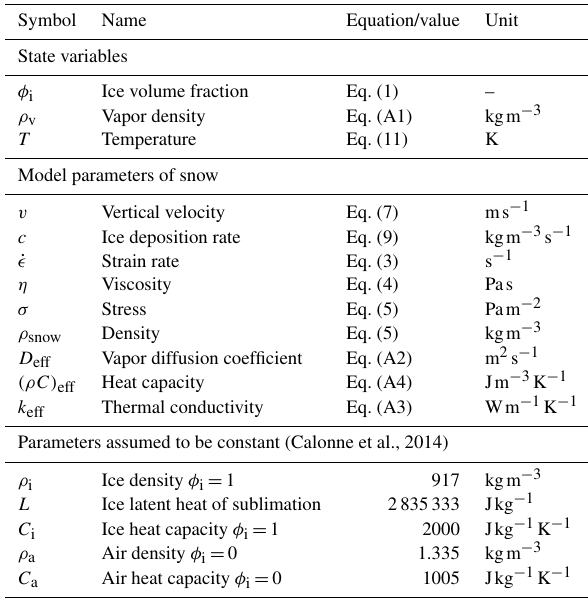
Table 1. Terminology of state variables, model parameters and con-